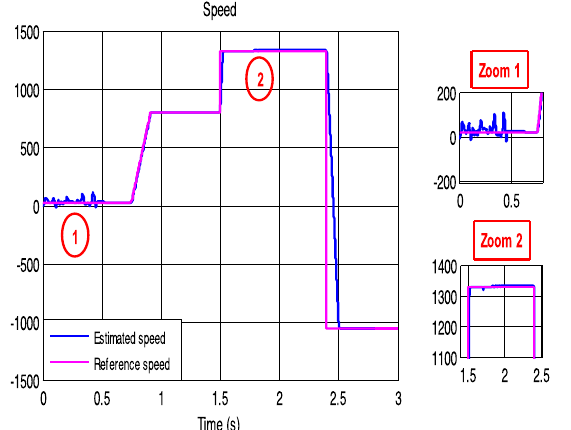
Fig. 21 PI-DTC-SPWM with five-level inverter estimated speed response